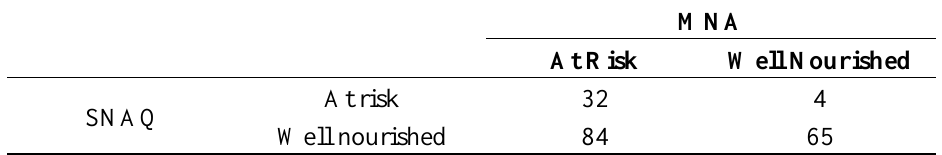
Table 2. Contingency table presenting classification of nutritional status of ambulatory rehabilitation participants by SNAQ and